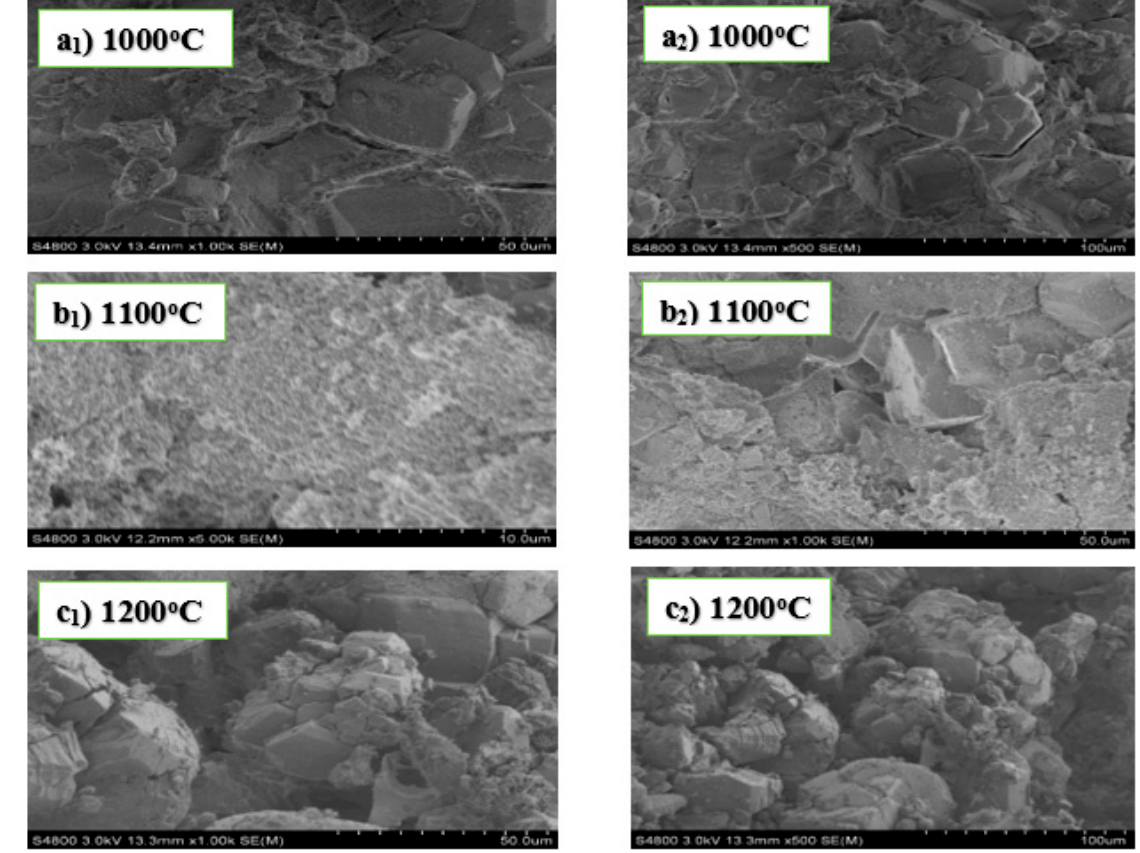
◦ C ( b ◦ C ( c 1 , a 2 ), 1100 1 , b 2 ), and 1200 1 , c 2